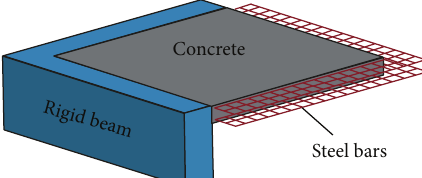
Figure 1: Numerical model of RC two-way bending slabs in a quarter form.